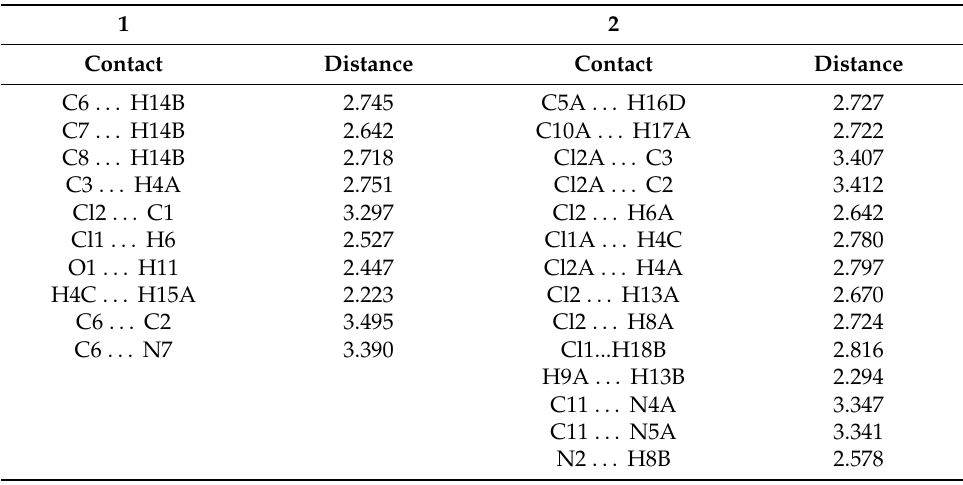
Figure 8. Hirshfeld surfaces of complex 2 . Table 4. The most important contacts in complexes 1 and 2 .